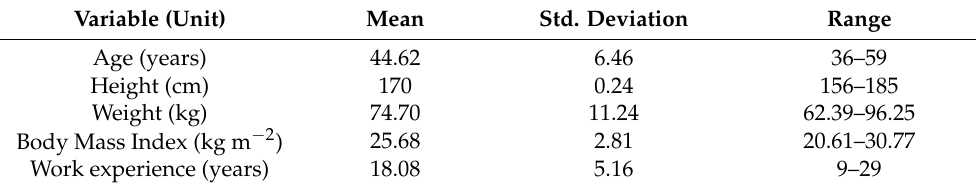
Table 3. Subject information (n = 13).